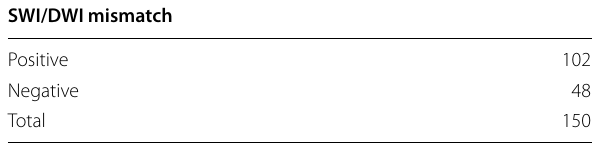
Table 4 SWI/DWI mismatch